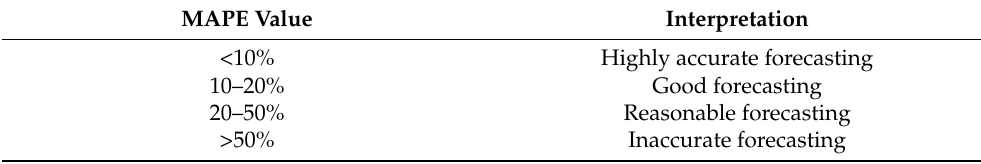
Table 1. Mean absolute percentage error (MAPE) values and interpretation. MAPE Value